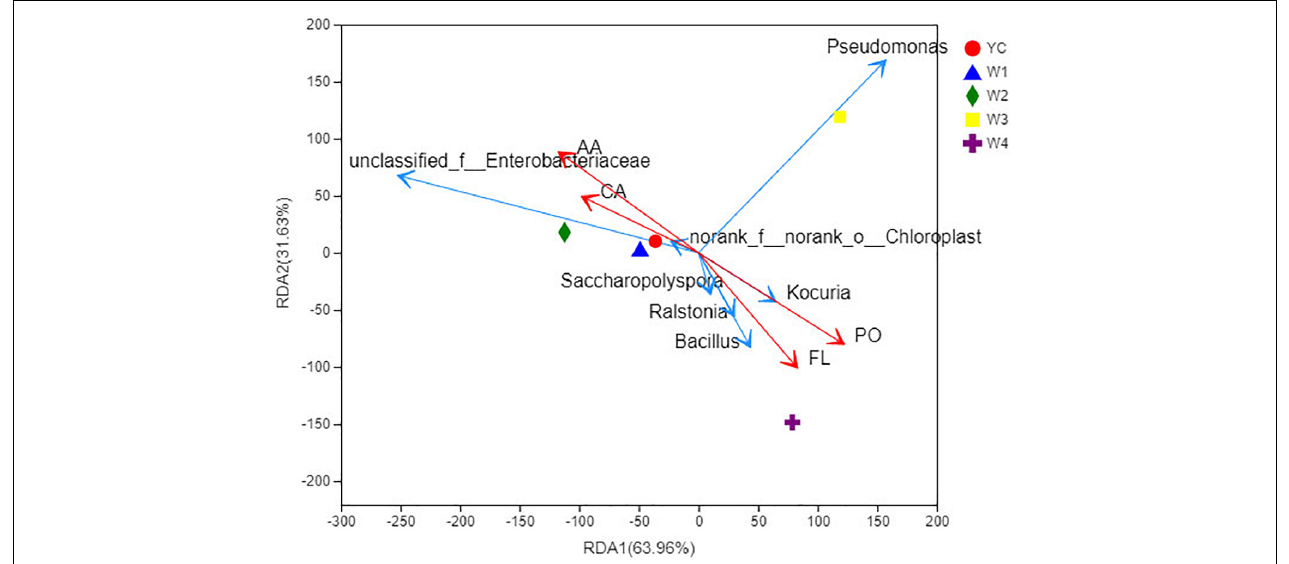
FIGURE 5 | RDA at the genus level. Points of different colors or shapes represent sample groups under different environments or conditions in the figure; taxa are represented by green arrows in the RDA diagram; quantitative environmental factors are represented by red arrows. The length of the environmental factor arrow can represent the degree of influence of the environmental factor on the taxa data; the angle between the environmental factor arrow represents the positive and negative correlation (acute angle: positive correlation; obtuse angle: negative correlation; right angle: no correlation). Projection from the sample point to the arrow of the quantitative environmental factor, the distance between the projection point and the origin, represents the relative influence of the environmental factor on the distribution of the sample community. PO, polysaccharides; FL, flavonoids; CA, caffeine; AA, amino acids.